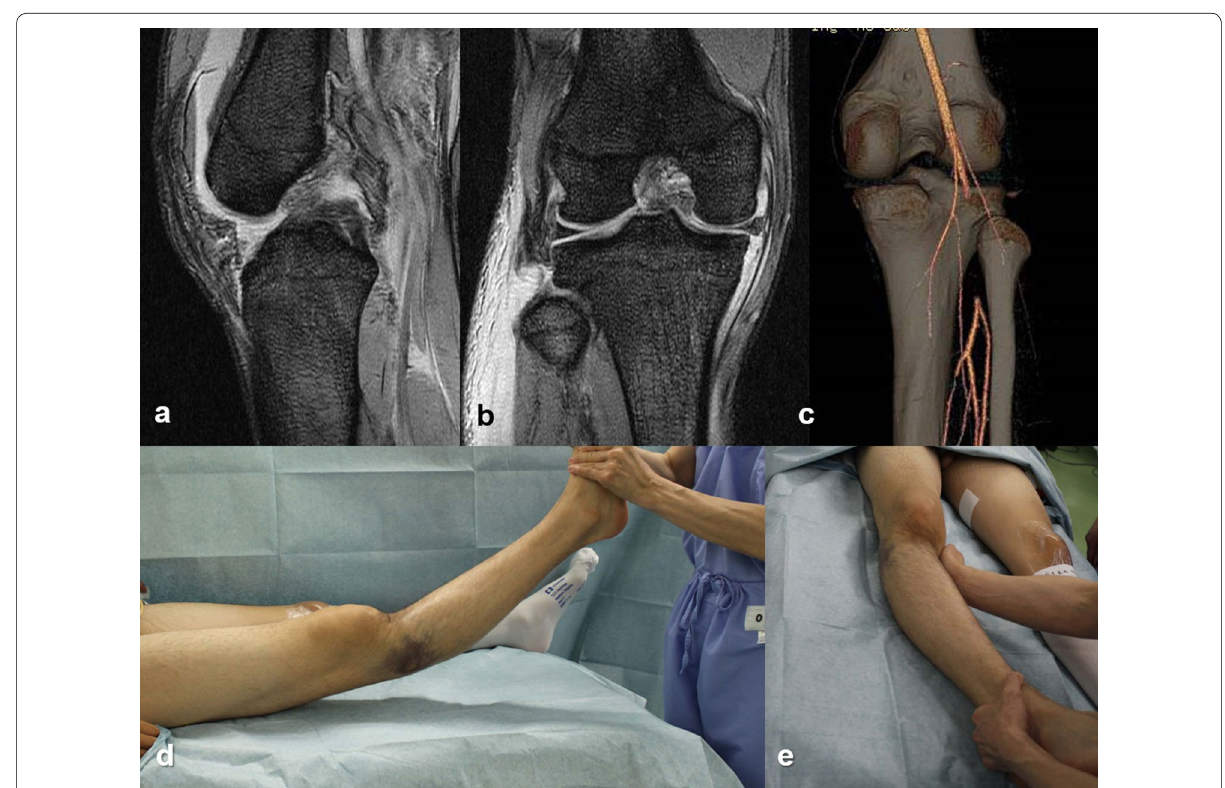
Fig. 2 MRI and CT angiography and evaluation under anesthesia. An 18-year-old baseball player who suffered multiligament knee injuries during a baseball game. a Sagittal MRI showing PCL injury and posterior capsular injury; b coronal MRI revealing avulsion of the posterolateral complex from the fibular head; c angio-CT revealing occlusion of the popliteal artery; d , e evaluation under anesthesia showing severe posterior and varus